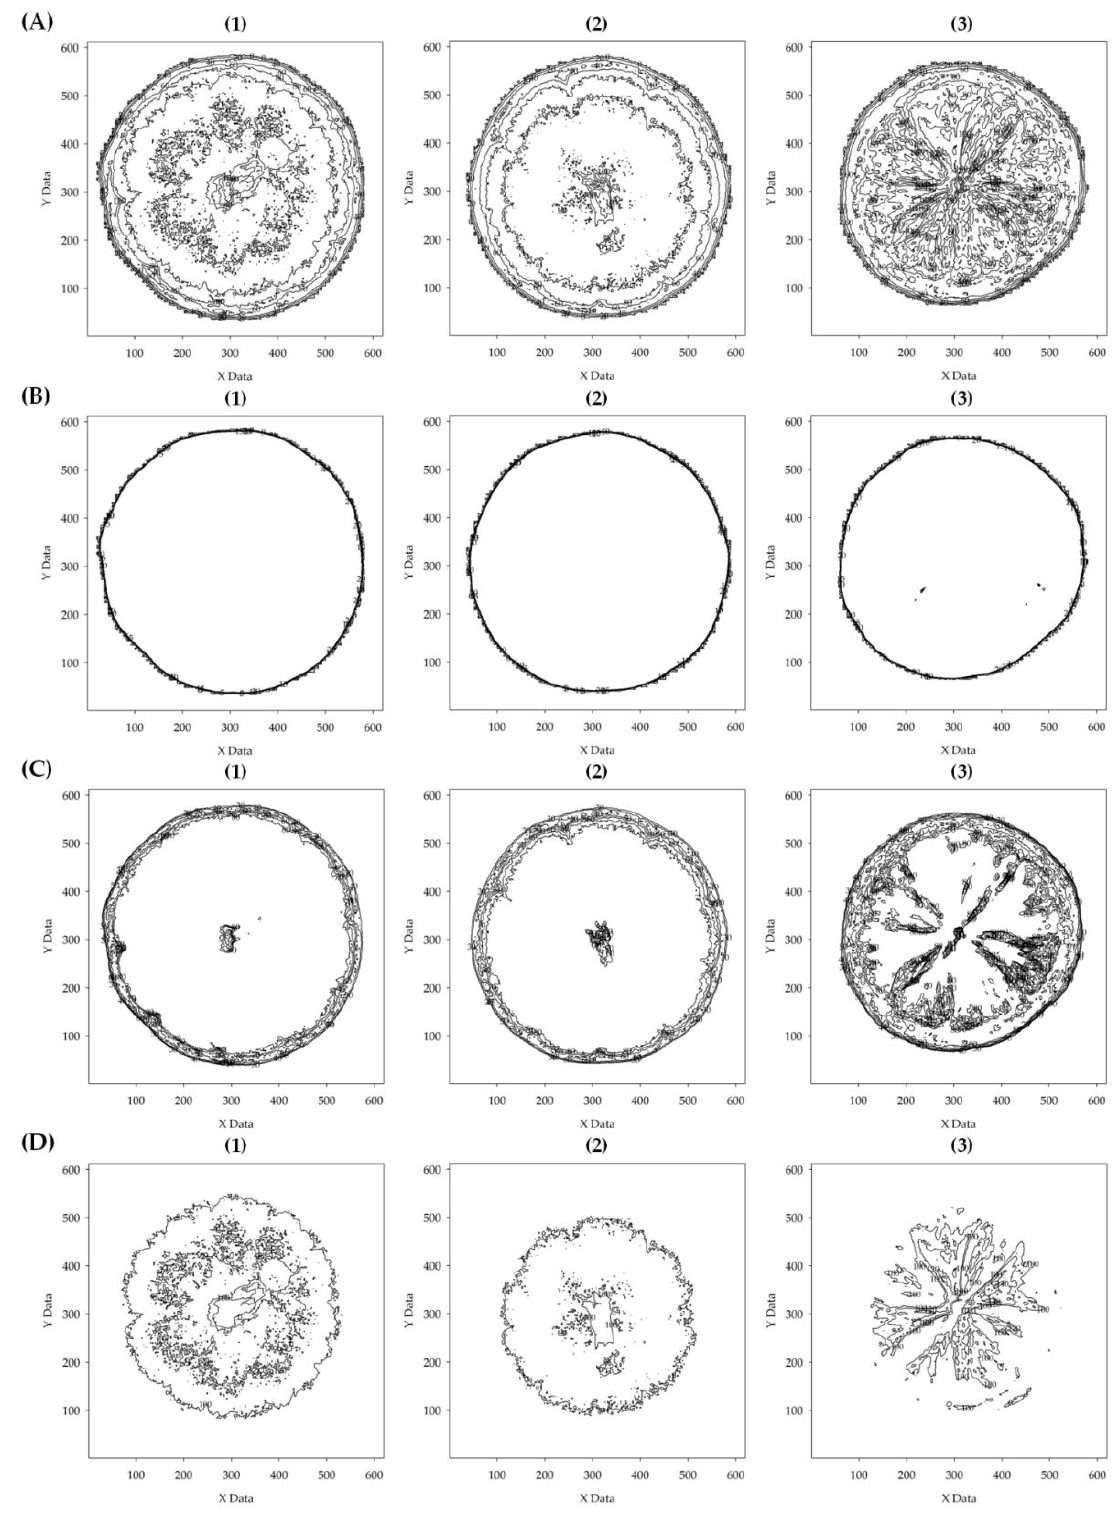
Figure 4. Axial-plane images of (1) fresh, (2) mature, and (3) overripe lemons to visualize the results of stratification analyses of the grayscale values, including ( A ) visualization diagrams of the lemon data, ( B ) visualization diagrams of the peel data, ( C ) visualization diagrams of the fiber data, and ( D ) visualization diagrams of the pulp data.